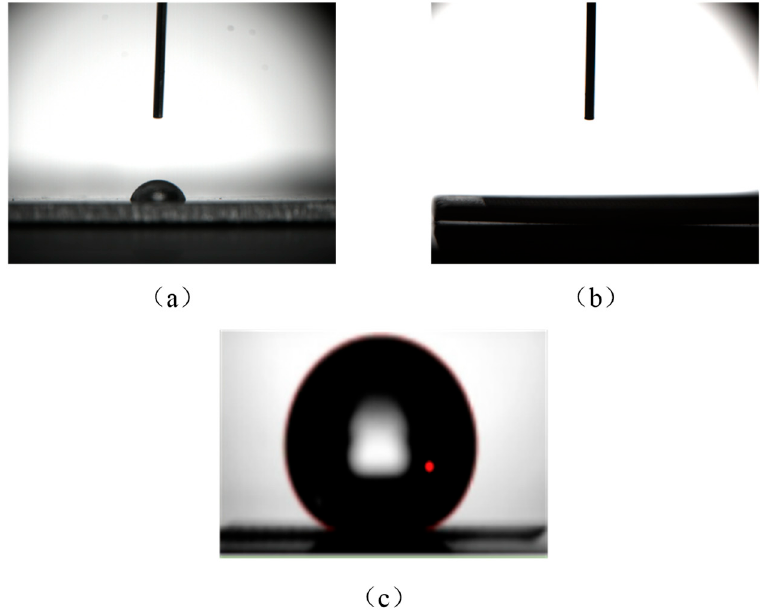
Figure 5. Diagram of contact angles of different surfaces: ( a ) untreated surfaces; ( b ) superhydrophilic surface; ( c ) superhydrophobic surface.